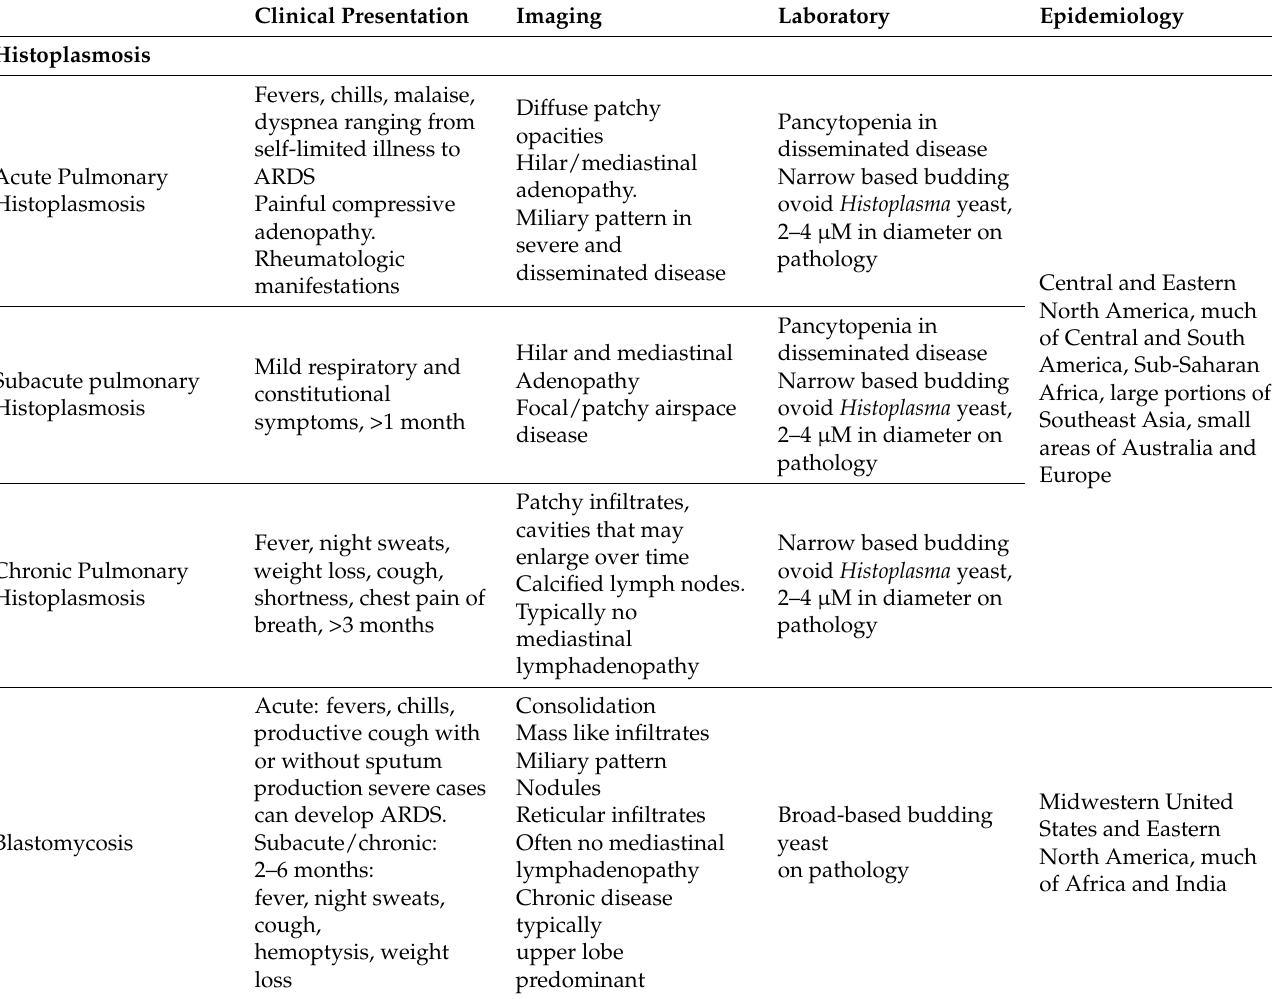
Table 1. Signs, symptoms, imaging and lab findings, and epidemiology of pulmonary infections due to endemic mycoses *. Clinical